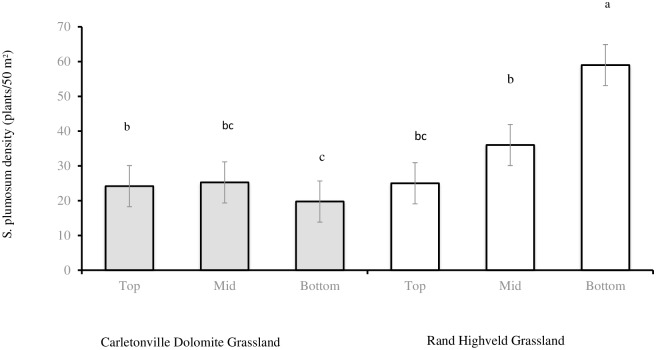
Seriphium plumosum density at CDG (n = 36) and RHG (n = 36) slopes sites.Bars represent standard error (SE). Same letters on the bars mean that P > 0.0500.